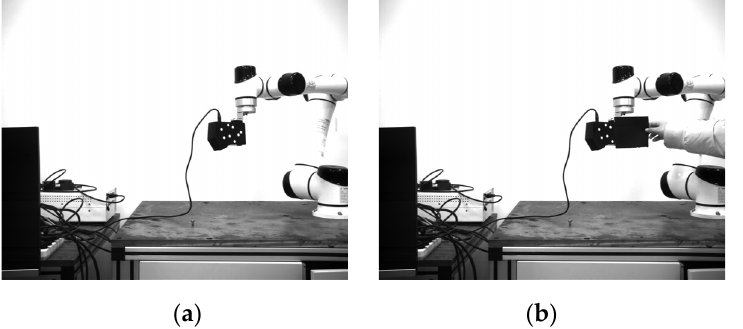
Figure 15. Left camera image at a rotation angle of 30°. ( a ) In the case of no occlusion. ( b ) In the case of the occlusion of two marker points.